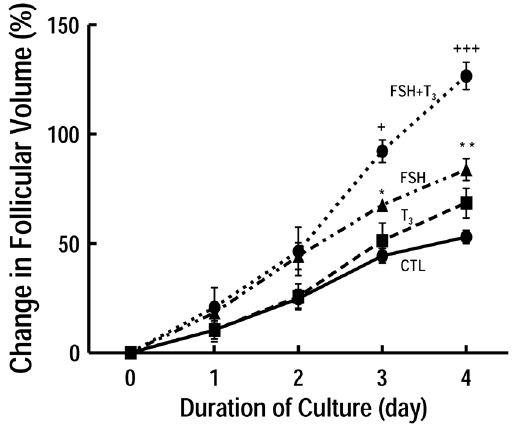
Figure 3. Effect of FSH and T 3 on preantral follicular growth in vitro. Preantral follicles were cultured for 4 days with or without FSH (10 ng/ml) and T 3 (1.0 nM). Follicles cultured in the absence of FSH and T 3 was named as CTL group. Follicular diameter was measured daily and results were expressed as change in follicular volume and represented as means 6 SEM of a total of 120 follicles from four independent experiments. Note that T 3 , while ineffective alone, significantly increased FSH-induced preantral follicular growth at Day 4 (P , 0.001). + P , 0.05, +++ P , 0.001 vs. FSH alone at the same culture duration, *P , 0.05, **P , 0.01, vs. CTL at the same culture duration (Three way